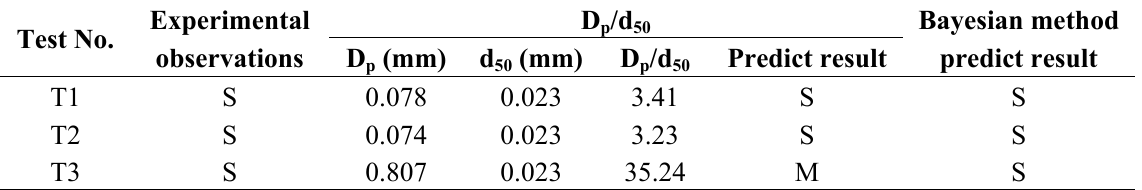
Table 4. Case verification results for different prediction